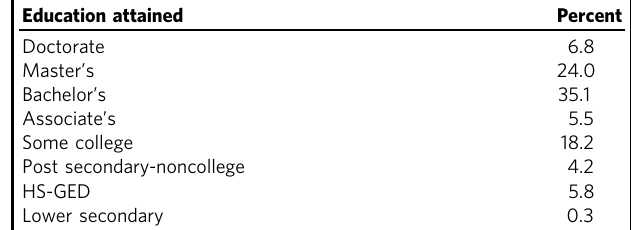
Table 2 Reported education